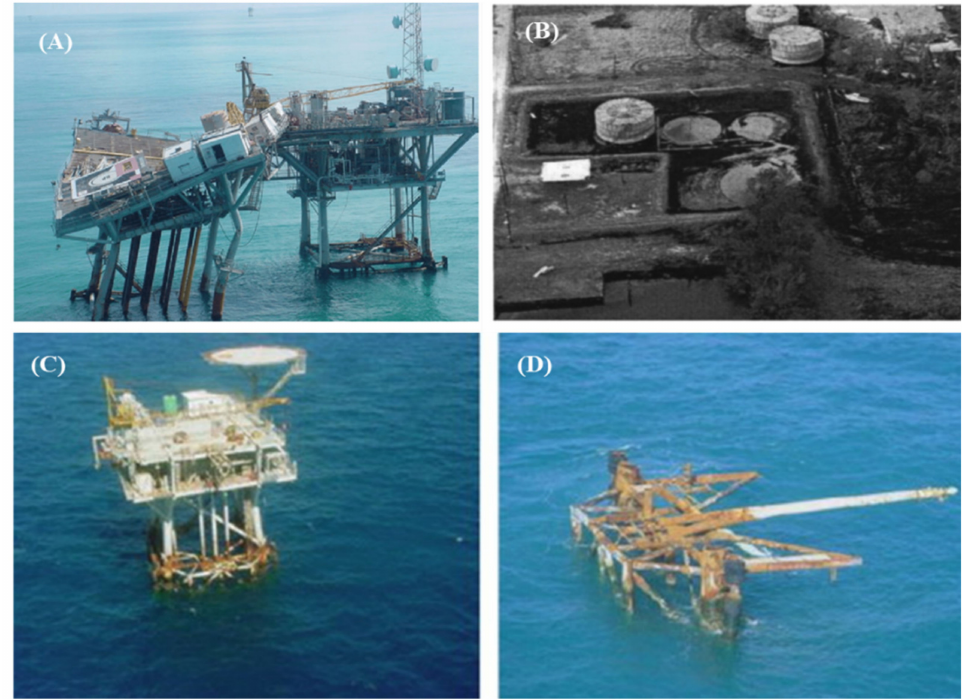
Figure 1. Examples of extreme storm impacts on coastal and offshore petroleum infrastructure: ( A ) offshore platforms were damaged during a hurricane off of Louisiana (reproduced under CC by 4.0 license, credit to Kaiser and Chambers [50]); ( B ) oil tanks were carried away by storm surge that caused over 1,750,000 L of oil release (reprinted with permission from“Alex Glostrum for the Louisiana Bucket Brigade”, credit to Godoy [51]); ( C , D ) before and after operating platform were destroyed during the 2005 hurricane season (reprinted with permission from Elsevier, credit to Kaiser and Kasprzak